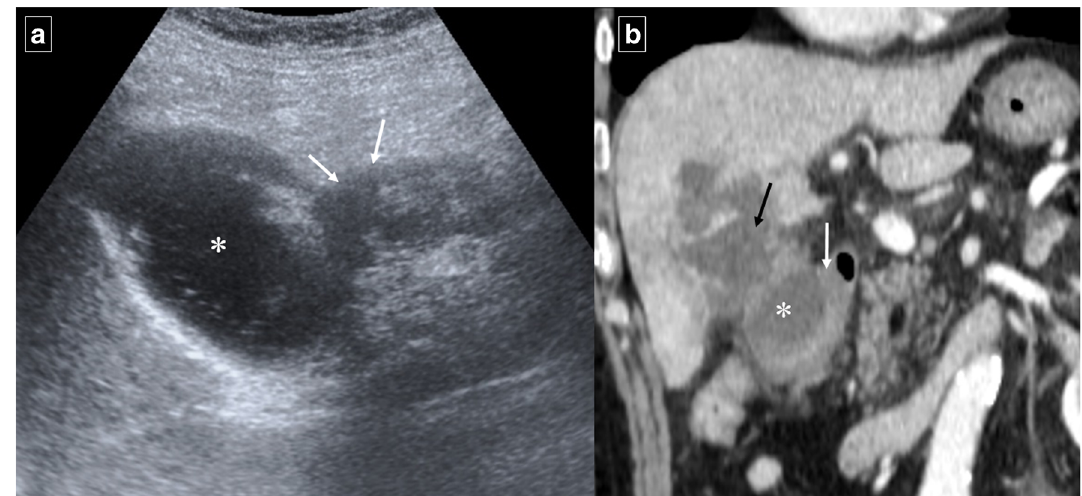
Fig. 19 Acute cholecystitis in a 54-year-old man. a Ultrasonography identified an enlargement of the lateral wall of the duodenum (white arrows) that was accompanied by a periduodenal fluid collection (*). b Reformatted coronal contrast-enhanced CT image shows a distended